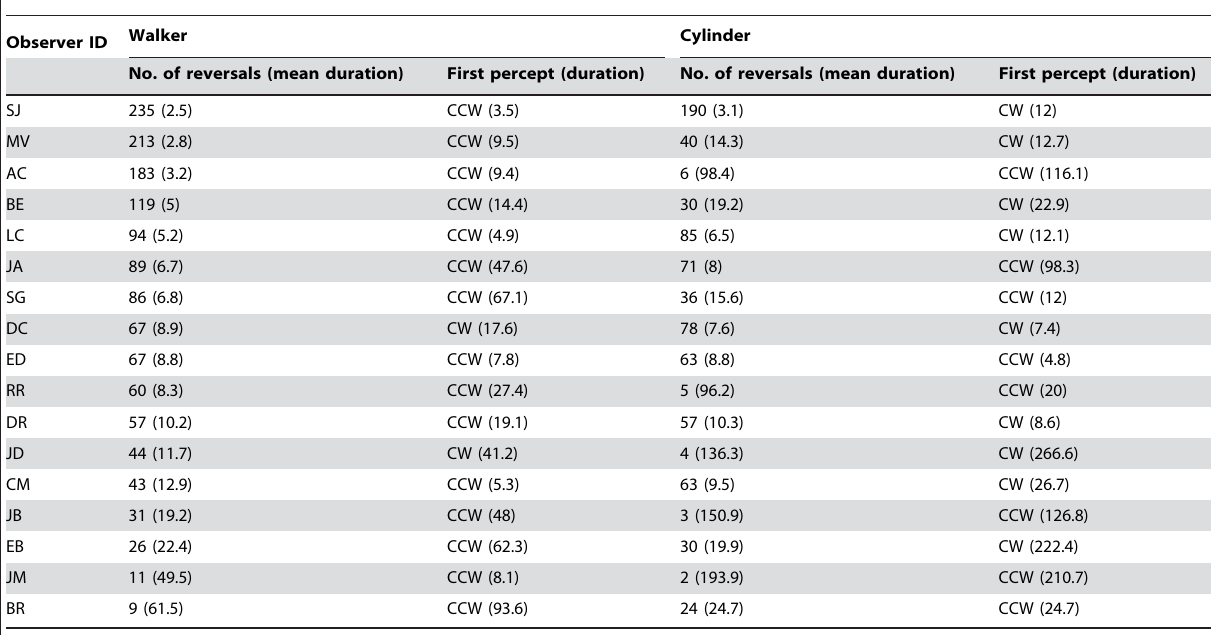
Table 1. Summary of reversal rates and first percepts in Experiment 1.